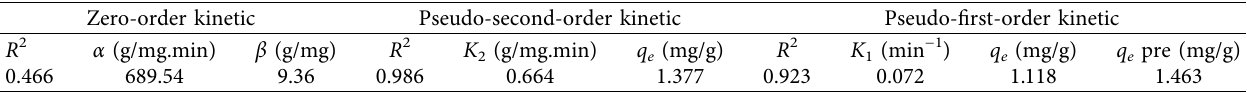
Table 8: Adsorption kinetic constants for TT